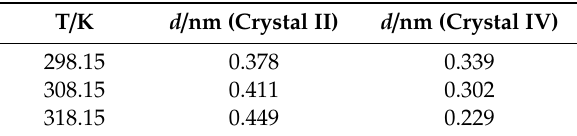
Table 6. Adsorption layer thickness of 2700 on two pyraclostrobin crystal particle surfaces at di ff erent temperatures.